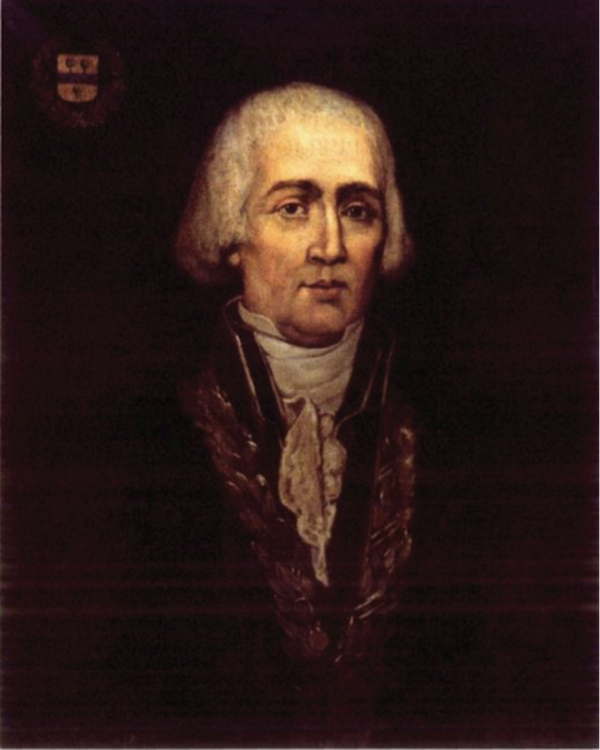
A photographic reproduction of an oil portrait of Guillaume-Antoine Olivier [source: Bernard (1997: fig. 1)].